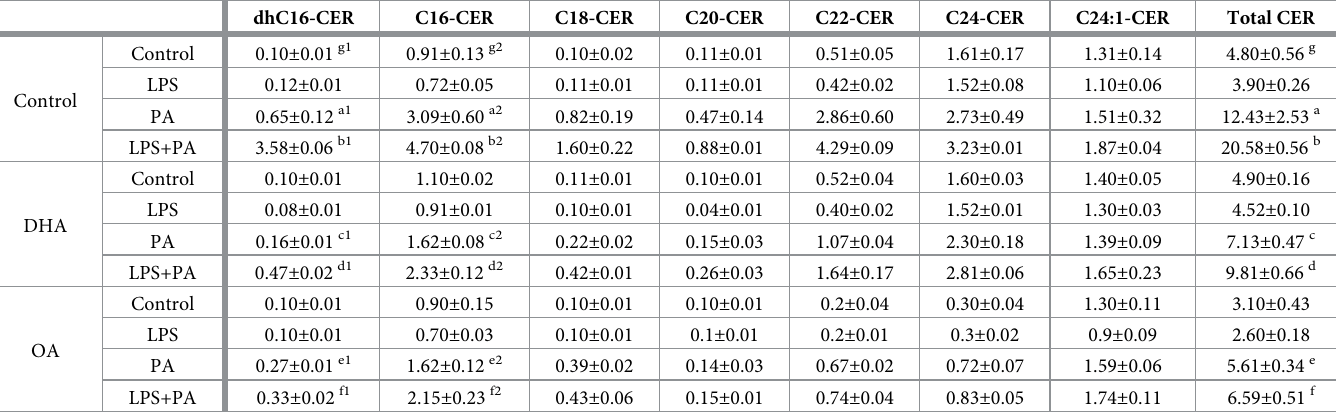
Table 2. The effect of DHA on CER content regulated by LPS, PA or LPS plus PA.